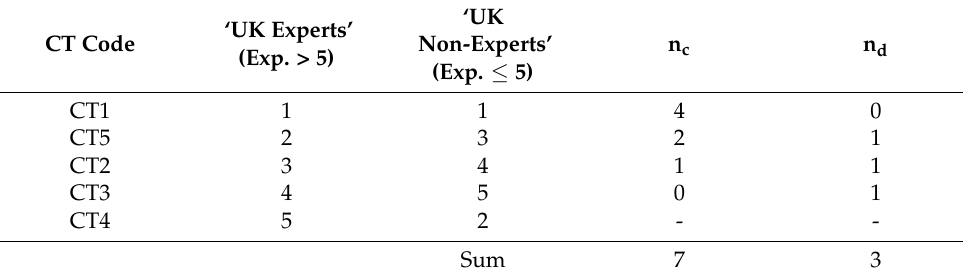
Table 9. Kendall’s-tau coefficient of concordance for CTs level.